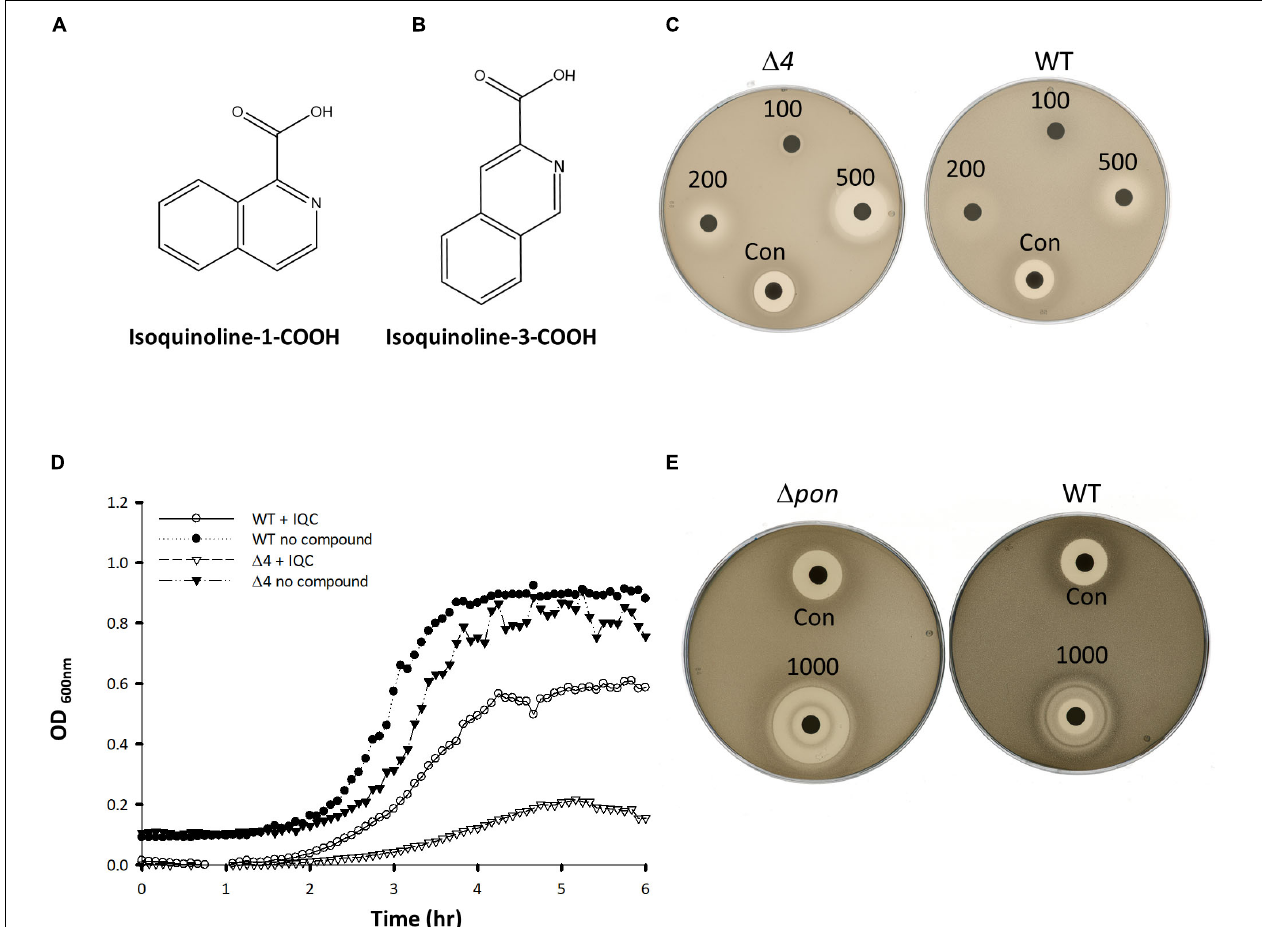
FIGURE 1 | Compound structures and effects on bacterial growth. (A,B) The structures of Isoquinoline-1-carboxylic acid (A) , and Isoquinoline-3-carboxylic acid (B) . (C,E) Disc assays showing the activity of IQC against the wild type (WT) and the (cid:49) 4 (C) and (cid:49) ponA (E) mutants. The radius of the inhibition zones for (cid:49) 4 at 500 µ g was 7 vs. 2 mm for the WT. In Panel (C) the values were 10 and 3 mm for the (cid:49) ponA and WT strains (1000 µ g disc), respectively. Numbers refer to the amounts of IQC added to the discs ( µ g). CON, Citrox (5 µ L). (D) Effect of IQC (40 µ g mL − 1 ) on growth of wild type and mutant strains in liquid culture.